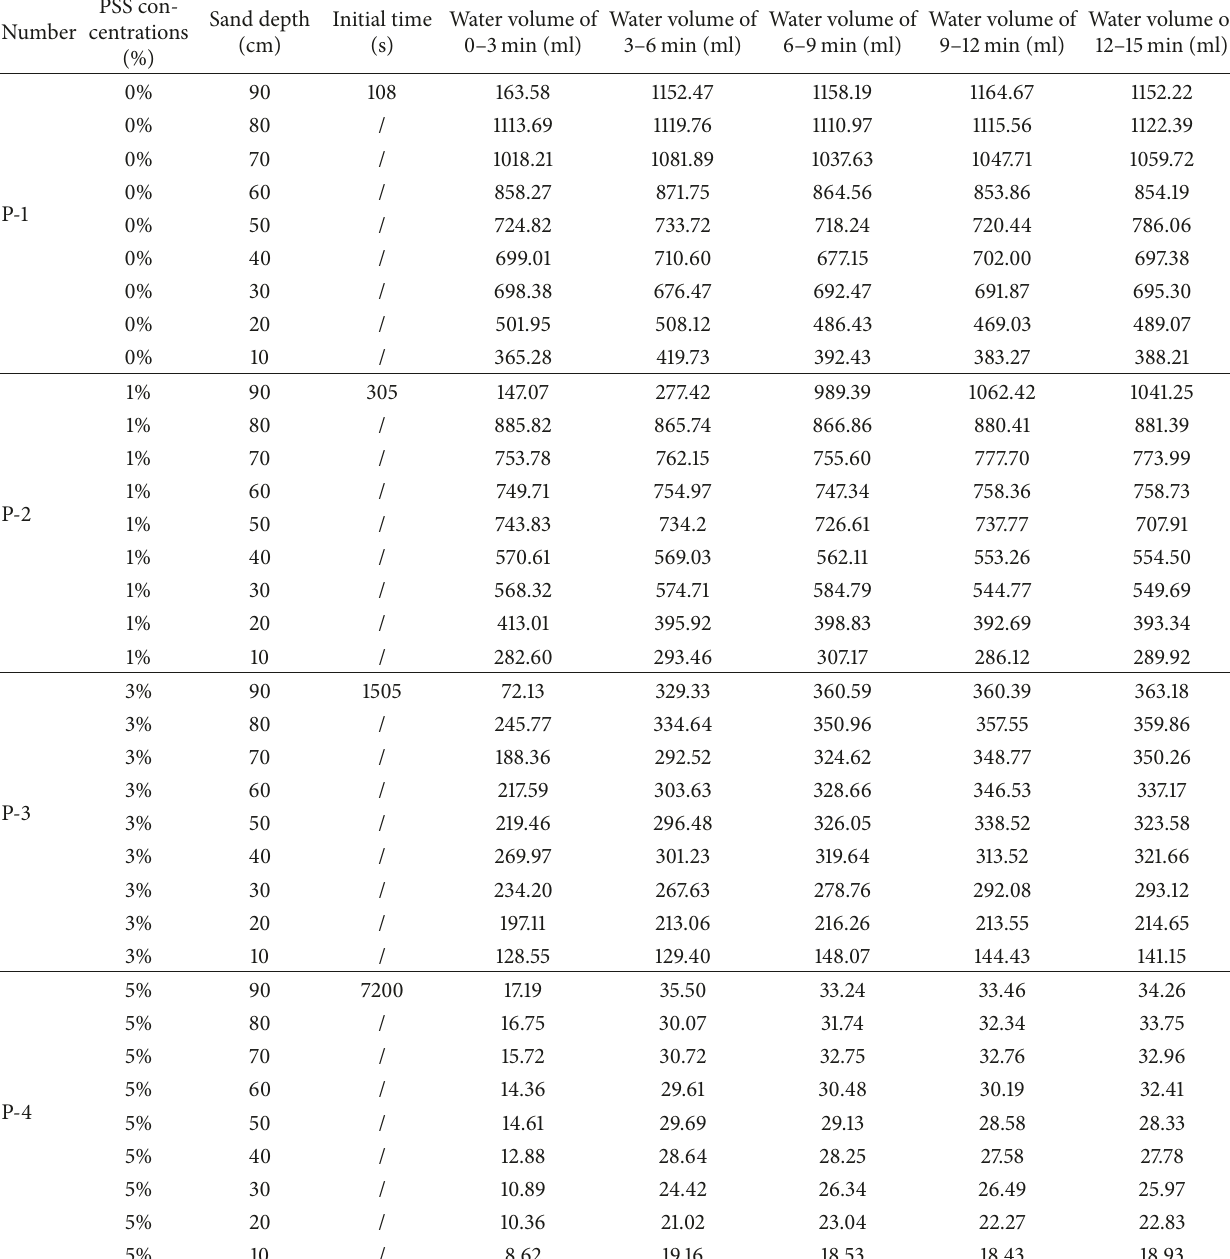
Table 4: Results of porous permeability